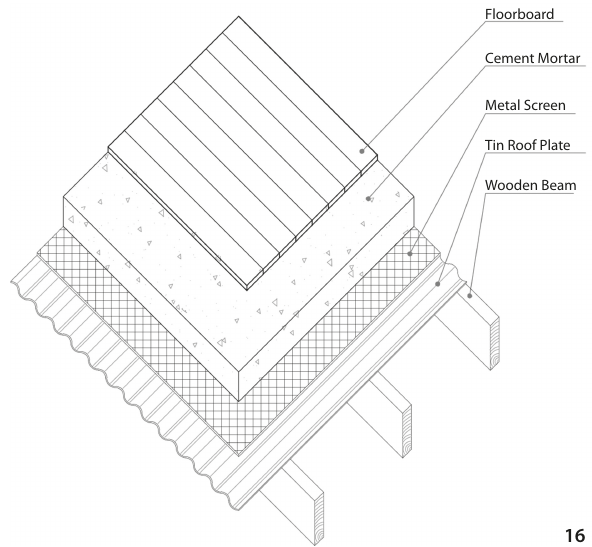
Figure 16 Deployé constructive system illustrated (Source: Instituto Pedra, 2015). not to